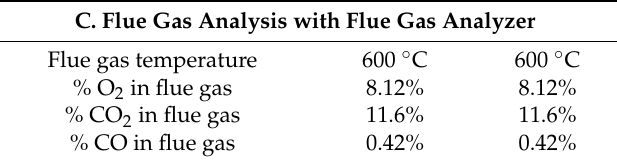
Table 6. Flue gas analysis data (Chetan et al.,